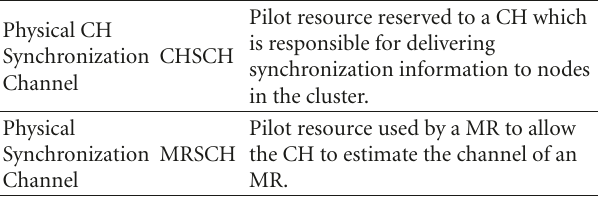
Table 5: Additional physical channels.